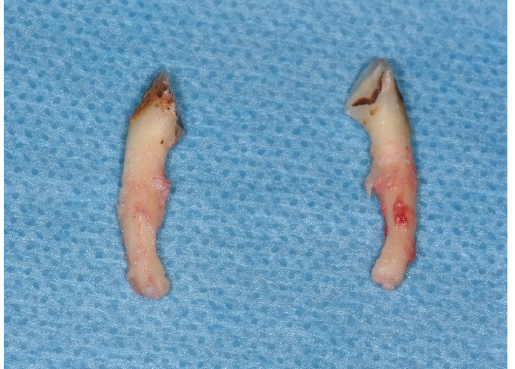
Figure 1. Right and left third incisor teeth on the sheep’s mandibula were extracted.